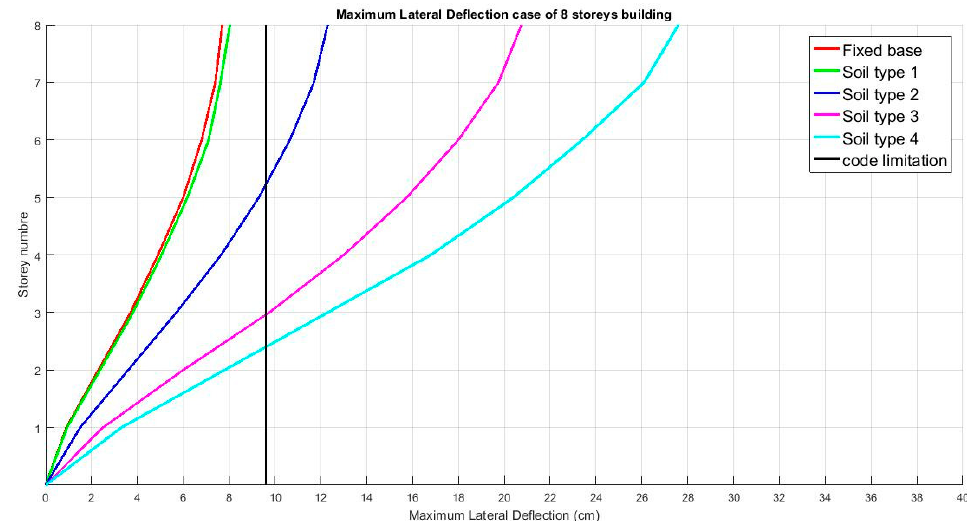
Figure 6. Maximum lateral deflection case of an 8-story building.